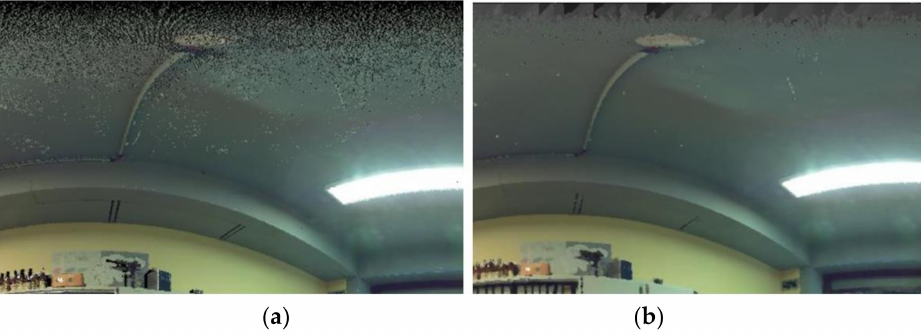
Figure 20. Noise elimination by median filter: ( a ) before median filter; ( b ) after median filter.